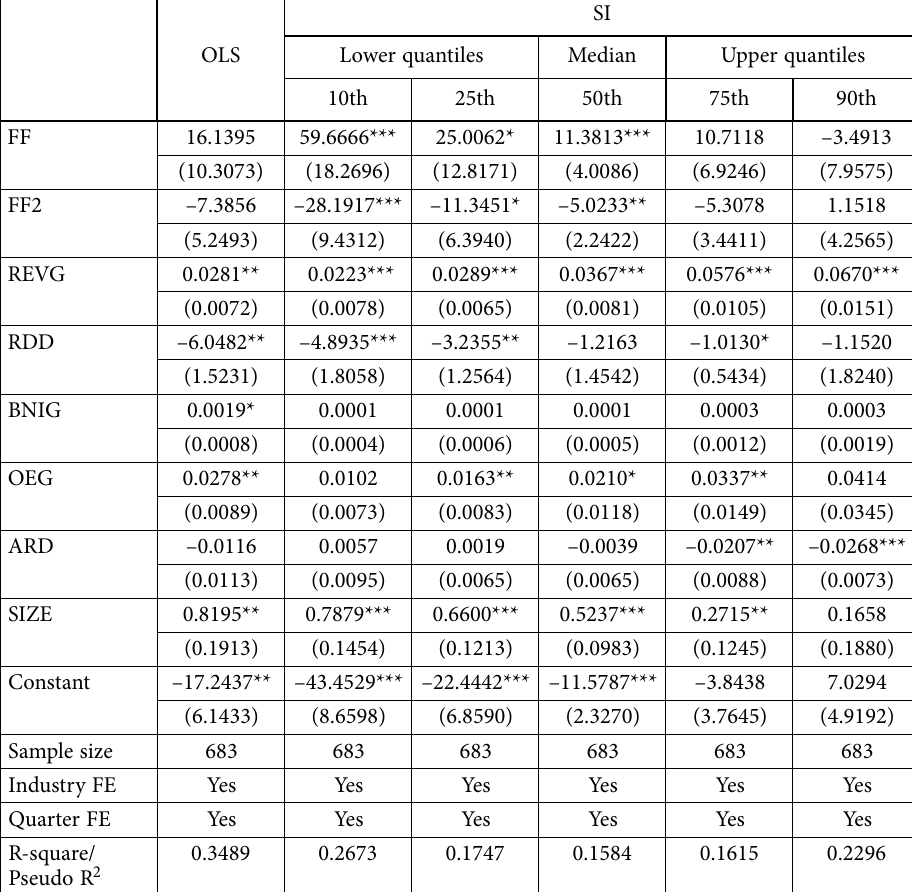
Table 4. OLS and QR results for the